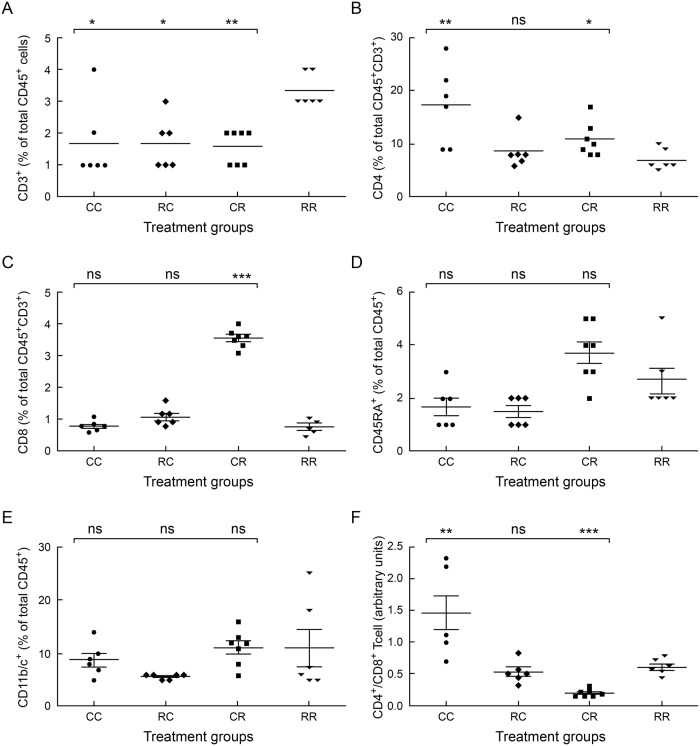
Pups from rrRSV-infected mothers exhibit skewed lower airway T cell populations during primary early-life rrRSV LRTI.Cells purified from BAL of 15-day old rat pups at the peak of rrRSV LRTI were profiled using flow cytometry to quantify populations of: (A) CD3+, (B) CD4+, and (C) CD8+ T cells; as well as (D) B cells and (E) monocyte lineage cells. (F) The mean CD4+/CD8+ T cell ratio is shown for each experimental group. Data for 3 experiments were combined and expressed as the mean ± SEM of ≥6 rats per group. Data are expressed as percentage of total CD45+ cells or total CD45+/CD3+ cells. Two-tailed student’s t test: *P<0.05, **P<0.01, ***P<0.001 compared to the RR group.